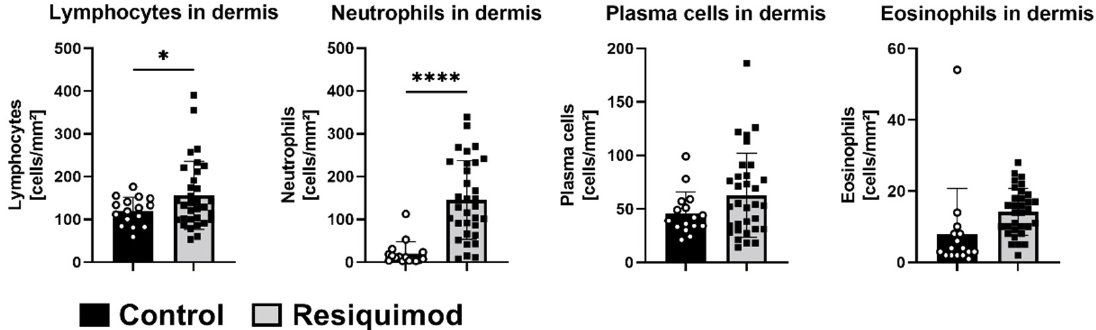
high immune cell infiltration and no visible skin layers except the dermis. Scale bar = 1 mm.